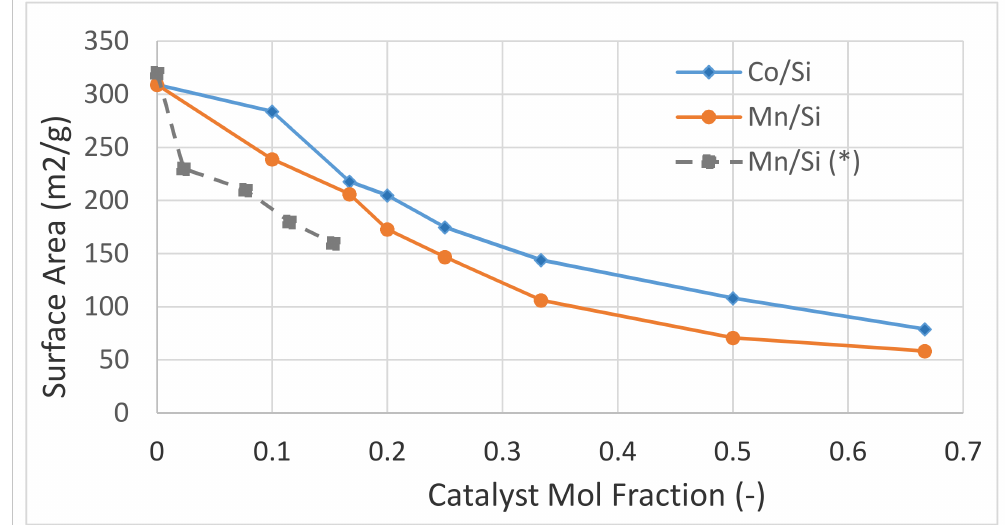
Figure 2. Variation of supported catalyst surface area with catalyst mol fraction for Co / Si and Mn /